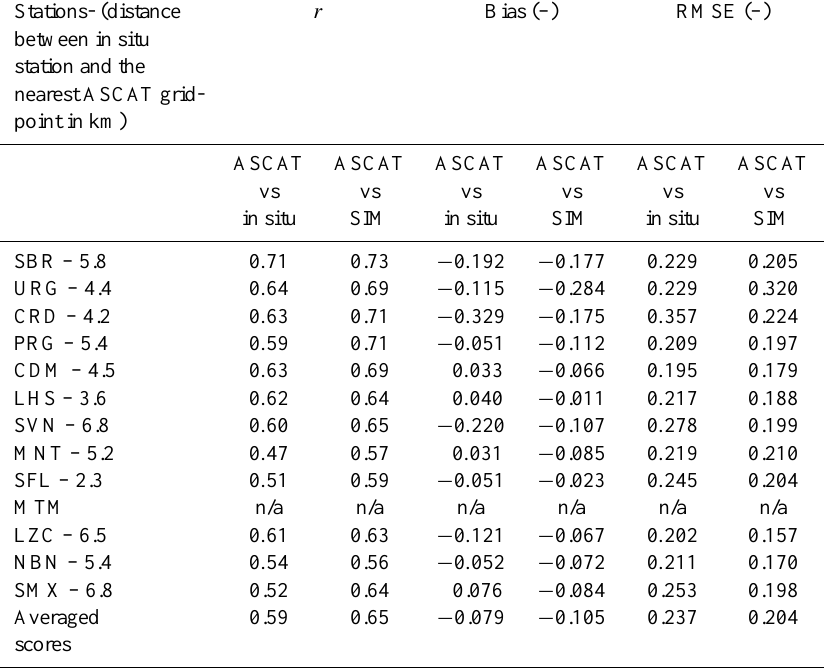
Table 3. Statistical scores for the comparison between either ASCAT and in situ (5cm) or ASCAT and SIM surface soil moisture (dimensionless as SSM data where rescaled, see paragraph 2.4 Data preparation) over a two year period (2007–2008) for 11 stations of the SMOSMANIA network and for the SMOSREX site. The last row is for the average of the 12 stations. Stations- (distance r Bias (–) RMSE (–) between in situ station and the nearest ASCAT grid- point in km) ASCAT ASCAT ASCAT ASCAT ASCAT